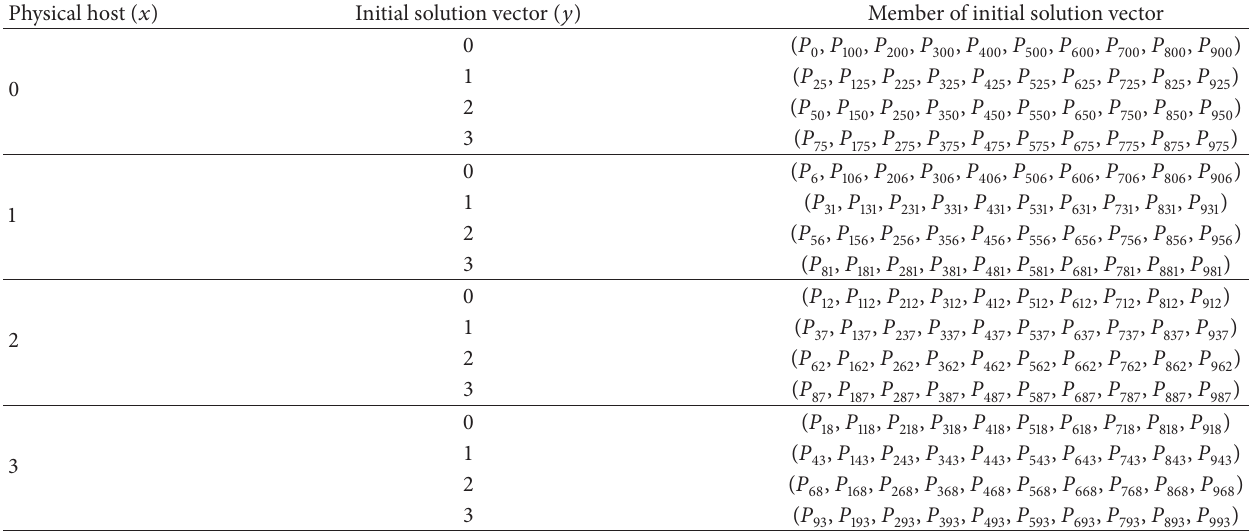
Table 1: An example of initial population in the first